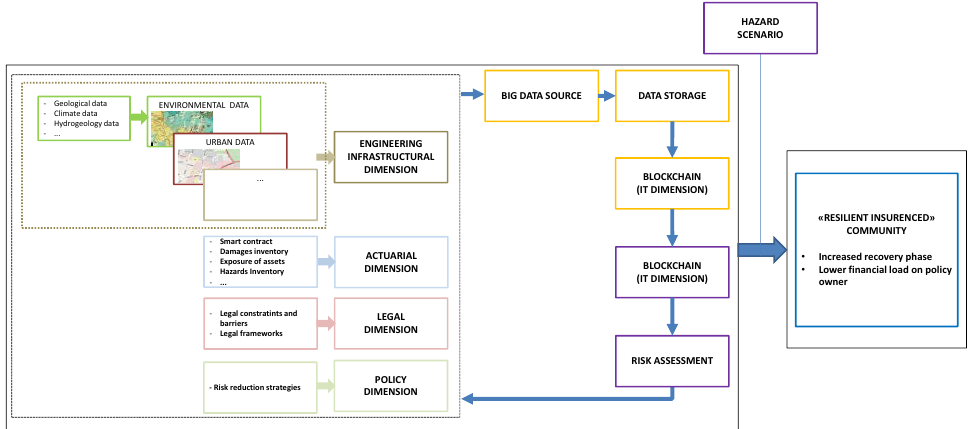
Fig. 1. Novel multi-disciplinary approach for blockchain